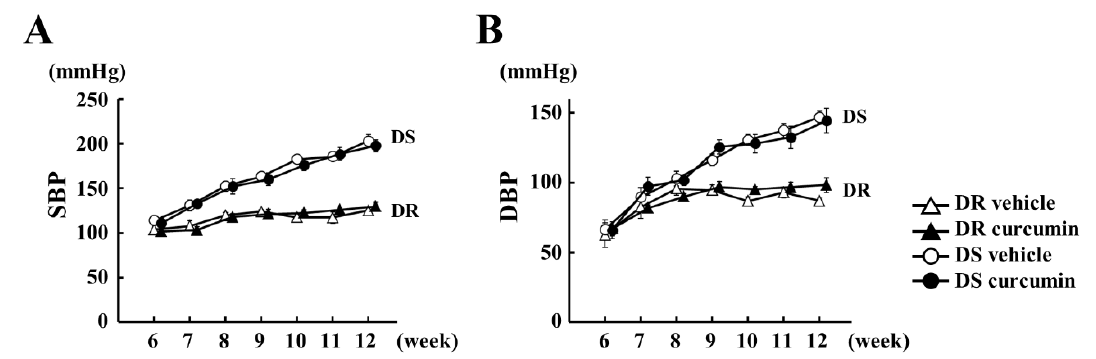
Figure 1. Curcumin treatment did not inhibit hypertension in Dahl salt-sensitive (DS) rats. ( A , B ) Blood pressure levels of DS and Dahl salt-resistant (DR) rats were examined by tail cuff methods in each group. The value expressed the mean ± standard error (SEM) from 5 DR and 8 DS rats in each group. White triangle: DR vehicle, black triangle: DR curcumin, white circle: DS vehicle, black circle: DS curcumin. SBP = systolic blood pressure. DBP = diastolic blood